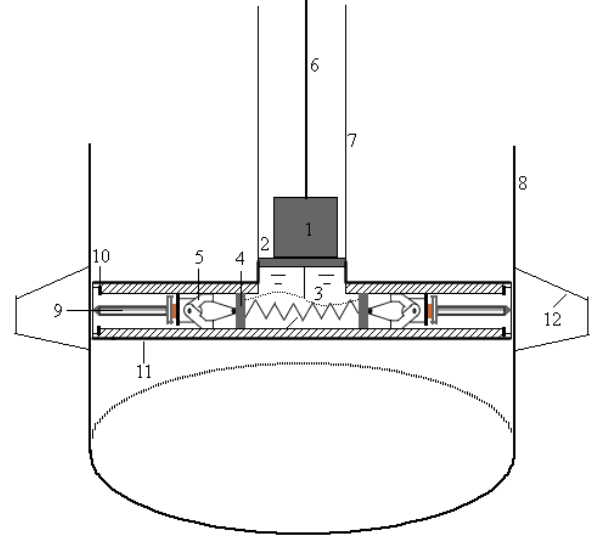
Figure 2. Schematic diagram of the distributor. 1. Weight; 2. Central pipe piston; 3. Springs; 4. Distributor piston; 5. Spring clips; 6. Wire cable; 7. Central pipe; 8. Production casing; 9. Heater; 10. Spacing seat; 11. Distributor; 12.